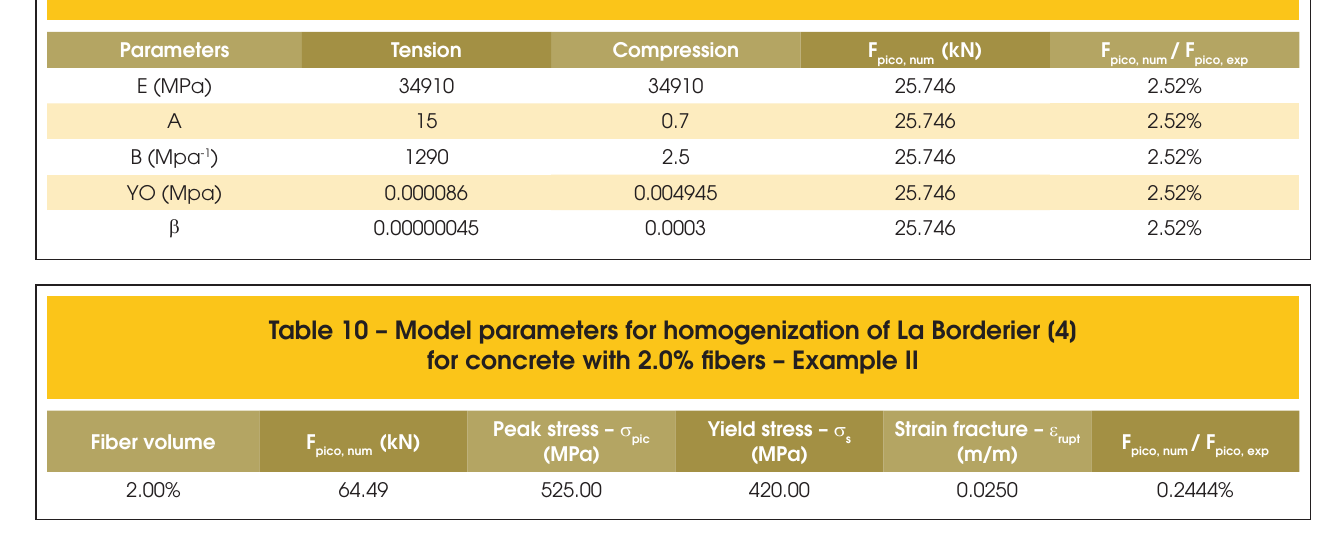
Table 9 – Damage parameters and elastic modulus of concrete without fibers identified from